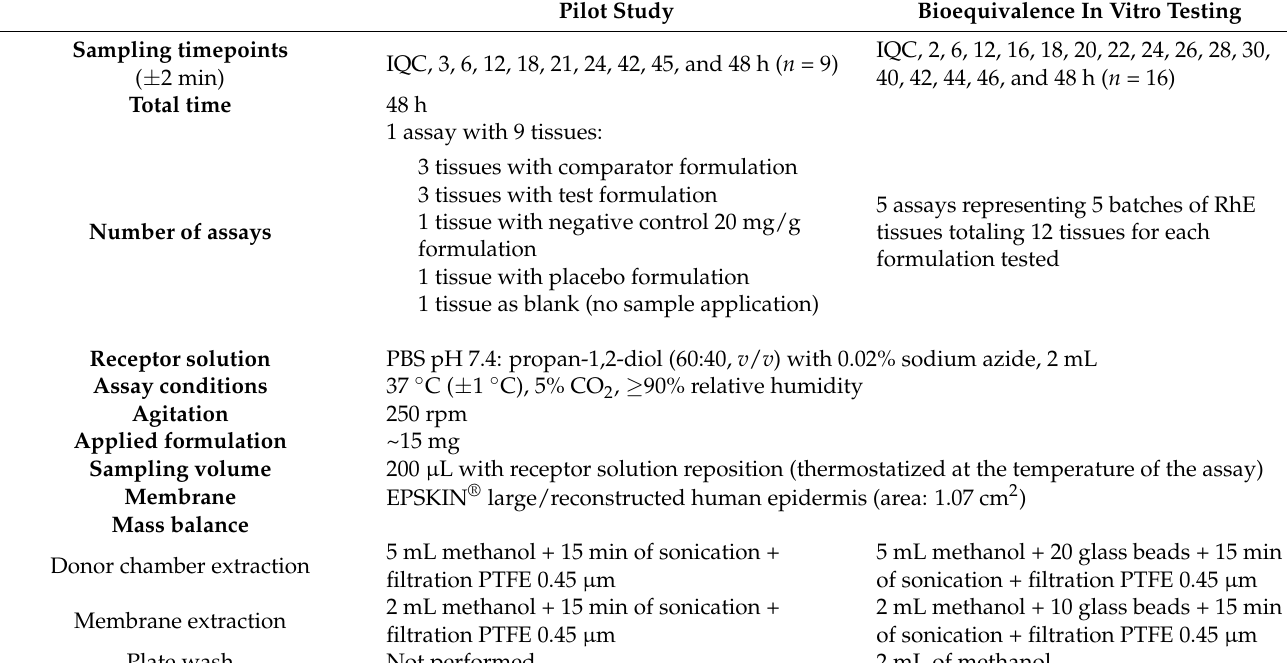
Table 1. Assay conditions used for the pilot study and for bioequivalence in vitro permeation testing. Pilot